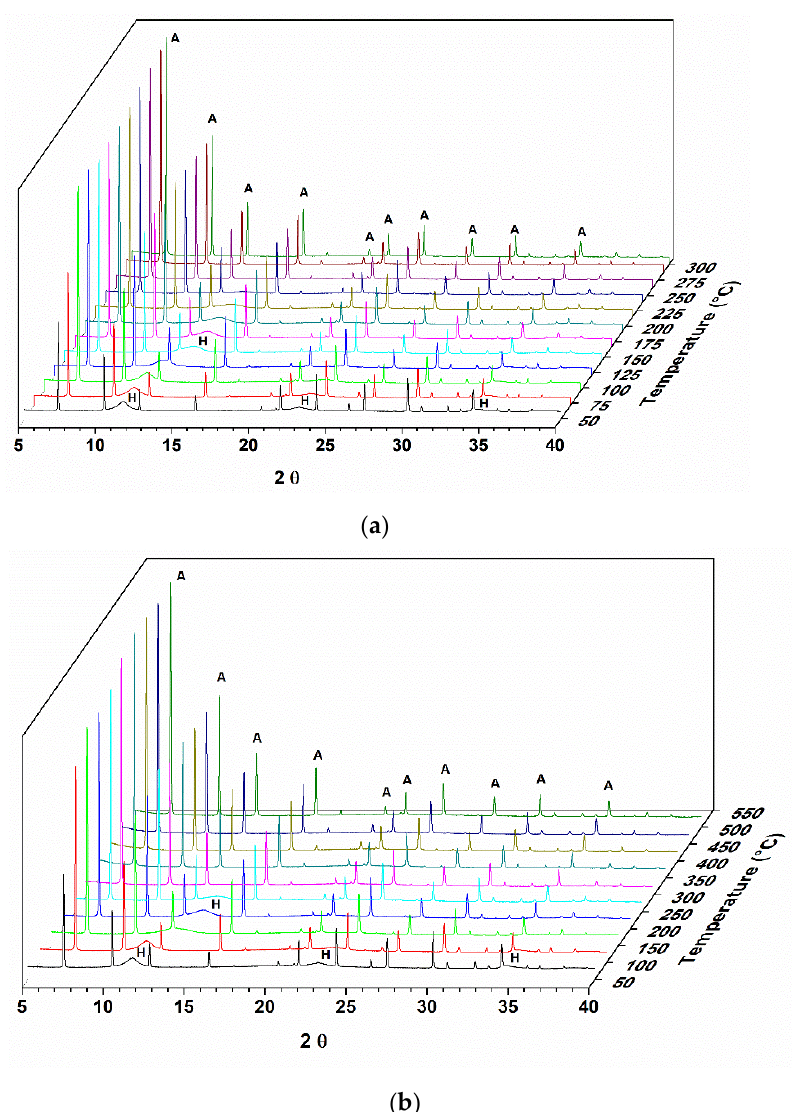
Figure 9. Diffractograms of the physical mixture of 50 wt% LDH and zeolite A: ( a ) calcined under the flow of He and a temperature of 300 °C and ( b ) under the flow of O 2 and a temperature of 500 °C. The symbol (A) indicates the reflections belonging to the zeolite A phase and (H) indicates the reflections referring to the hydrotalcite phase. The planes (003), (006), and (009), characteristic of the LDH phase, are also indicated.